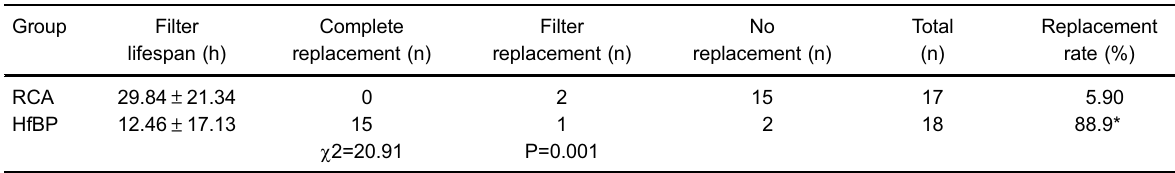
Table 4. Filter lifespan and the number of patients with multiple organ dysfunction syndrome treated with regional citrate anticoagulation (RCA) or heparin-free blood puri fi cation (hfBP) undergoing fi lter replacement.